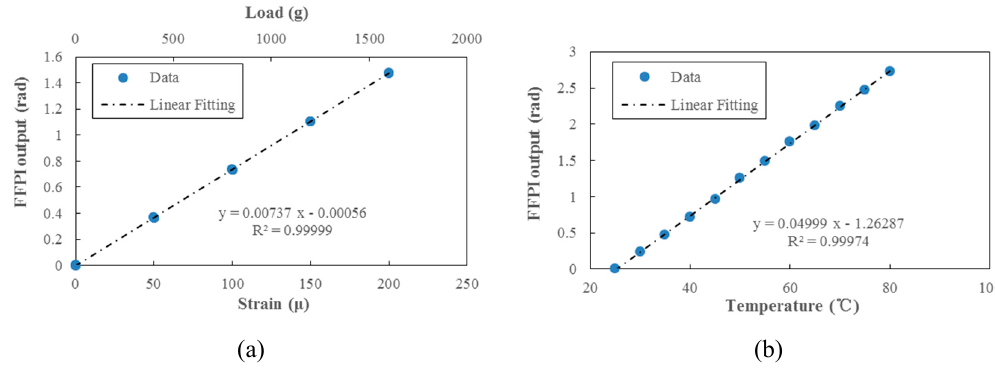
Figure 7. Results of ( a ) applied strain/load, and ( b ) temperature measurements of an FFPI strain gauge.